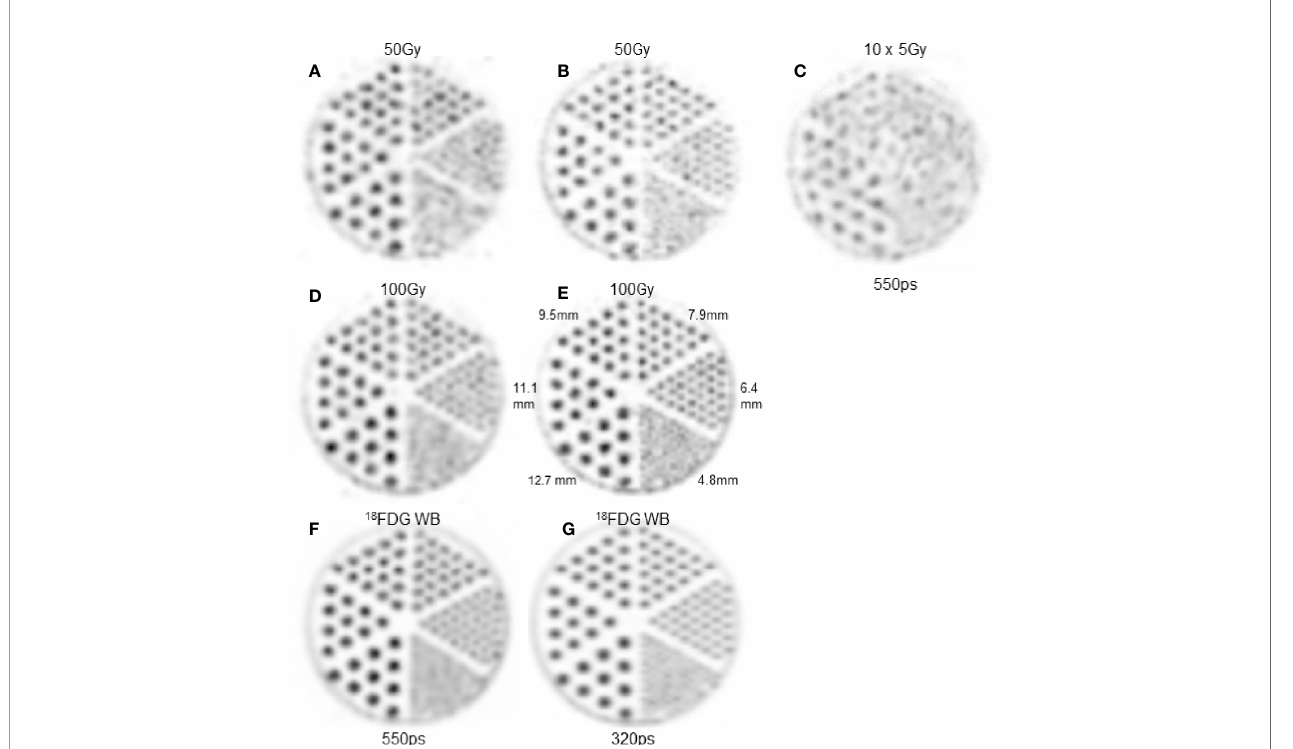
FIGURE 2 | Hot rod slice. (A, C, D, F) 550ps TOF-PET. B,E,H: 320ps TOF-PET. (A, B) 4mm-thick slice in 50Gy- 90 Y-setup. (D, E) 4mm-thick slice in 100Gy- 90 Y- setup. (C) 4mm-thick slice in 5Gy- 90 Y-setup with a 10 fold longer acquisition time. Note that the acquisition time increasing (C) did not counterbalance the count rate reduction and result in lower image quality than (A, D) . (F, G) 4mm-thick slice in clinical 18 FDG WB setup. As the intent is to show the capability of each modality to assess the heterogeneity pattern, the maximum voxel intensity of each image was scaled to 255.